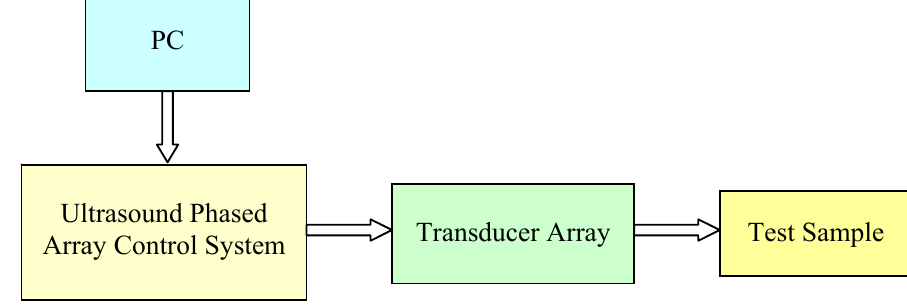
Figure 8. Schematic diagram of experimental